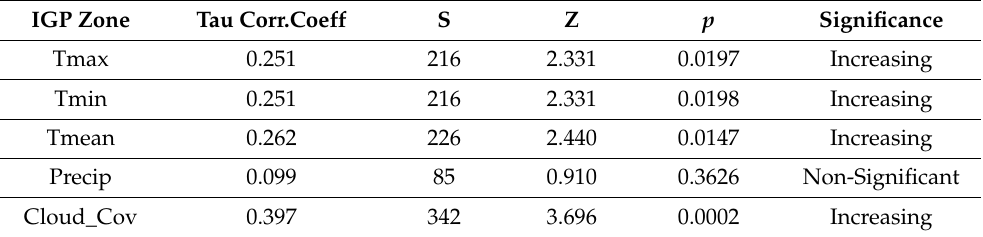
Table 10. Mann Kendall Trend Test of JJAS averaged climatic variable for IGP zone.